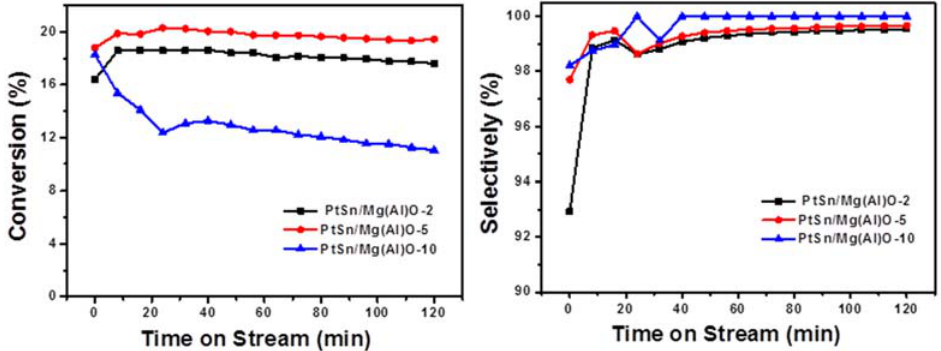
Figure 7. ( a ) Ethane conversion and ( b ) ethylene selectivity of PtSn/Mg(Al)O catalysts. Reaction conditions: 550 °C, 50 mg of catalyst, 0.2 bar C 2 H 6 , 0.8 bar N 2 , C 2 H 6 weight hourly space velocity (WHSV) of 12.9 h –1 .